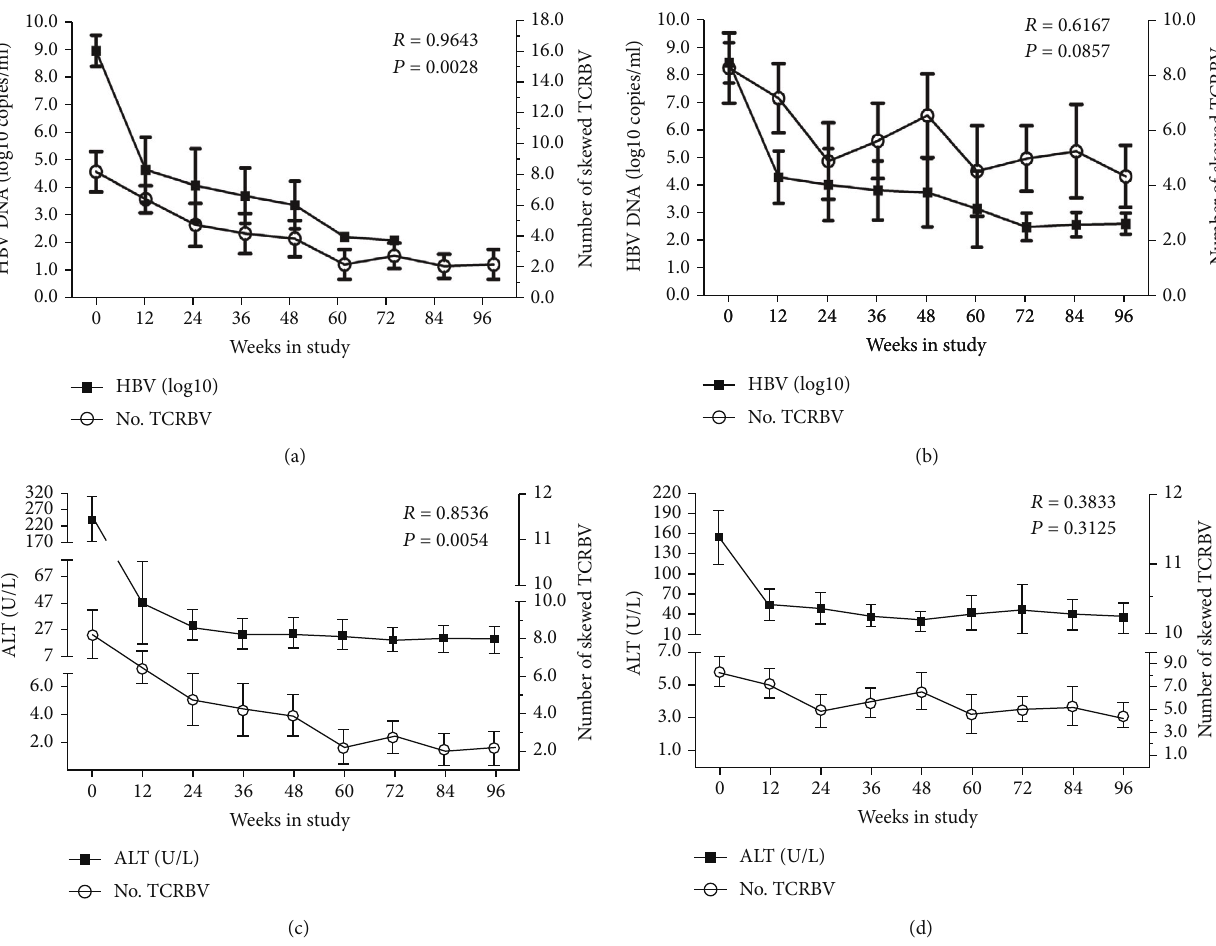
Figure 3: Association between the number of skewed TRBV families and the HBV DNA load or ALT level in HBeAg seroconverting (SC) or non-SC subjects during TDF treatment. The relationship between the HBV DNA level (log10 copies/mL) and the number of skewed TRBV families is shown for HBeAg SC (a) and non-SC subjects (b). The relationship between the ALT level (U/L) and the number of skewed TRBV families is shown for HBeAg SC (c) and non-SC subject (d). The x -axis indicates the di ff erent treatment time points; (a) and (b) on the left y -axis show the HBV DNA levels; (c) and (d) on the left y -axis show the ALT levels, and the right y -axis shows the number of skewed TRBV families. Correlations were analyzed using a Spearman correlation